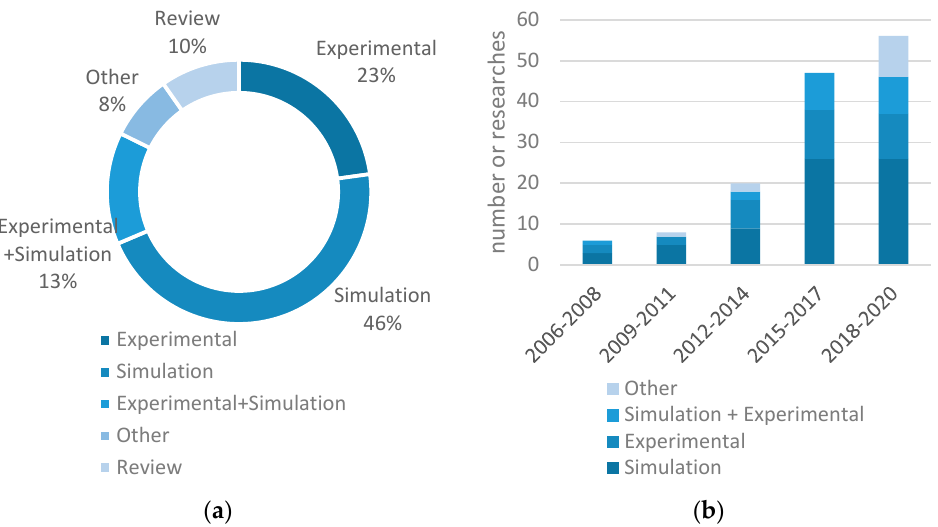
Figure 5. Share of used methods in ADBE research ( a ) and trend of used methods in research over the years 2006–2020 ( b